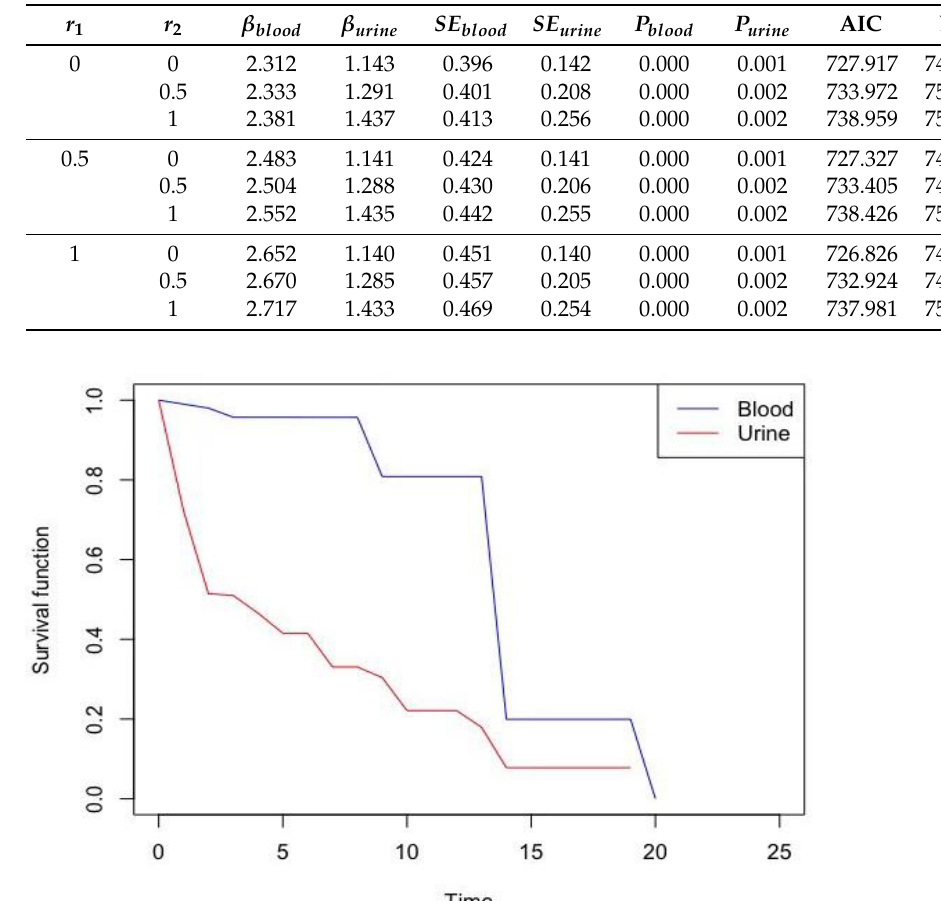
Figure 1. Estimated marginal survival functions for the CMV shedding times in the blood and